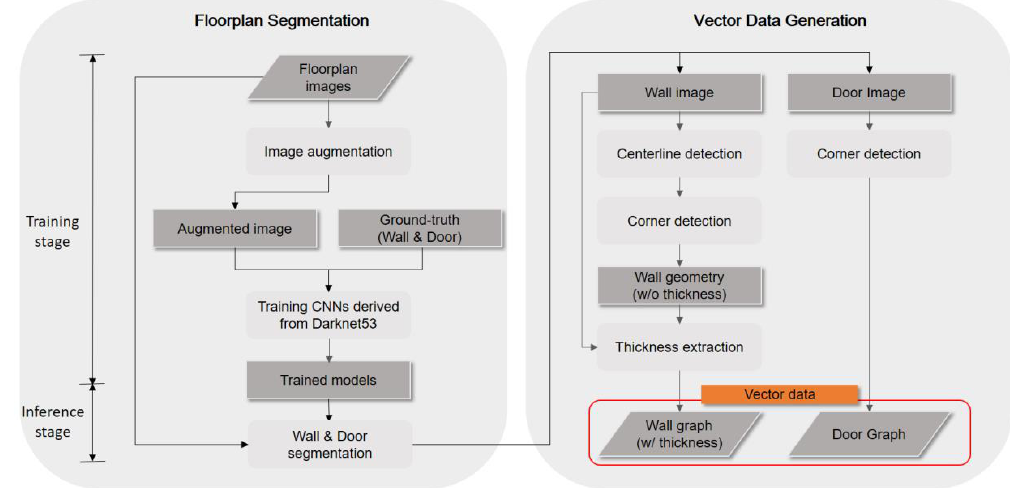
Figure 1. Workflow of the study, showing the input data, process, and results. Note: CNN = convolutional neural network. neural